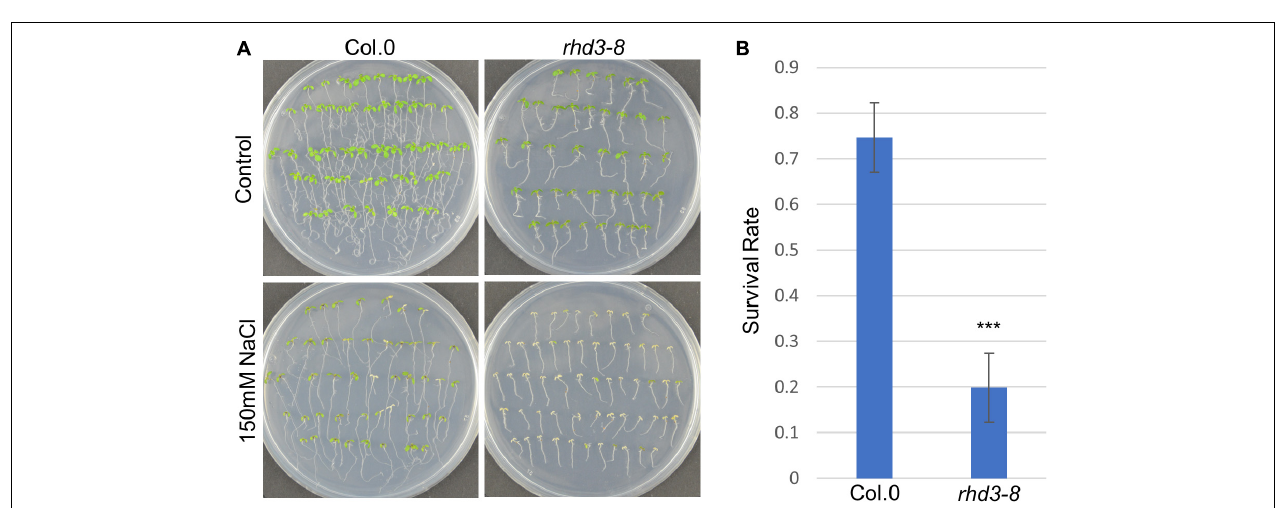
FIGURE 1 | rhd3 mutant is sensitive to endoplasmic reticulum (ER) stress. (A) Ten-day old seedlings of wild type (WT) and rhd3-8 grown on 1/2 MS in the absence (control) and presence of 2 mM dithiothreitol (DTT). (B) Quantification of survival rate of seedlings of WT ( n = 6, each time with 100–200 seedlings) and rhd3-8 ( n = 6, each time with 100–200 seedlings) grown under 2 mM DTT. Error bars represent SD, *** represents significant difference ( P -value < 0.001, t -test).